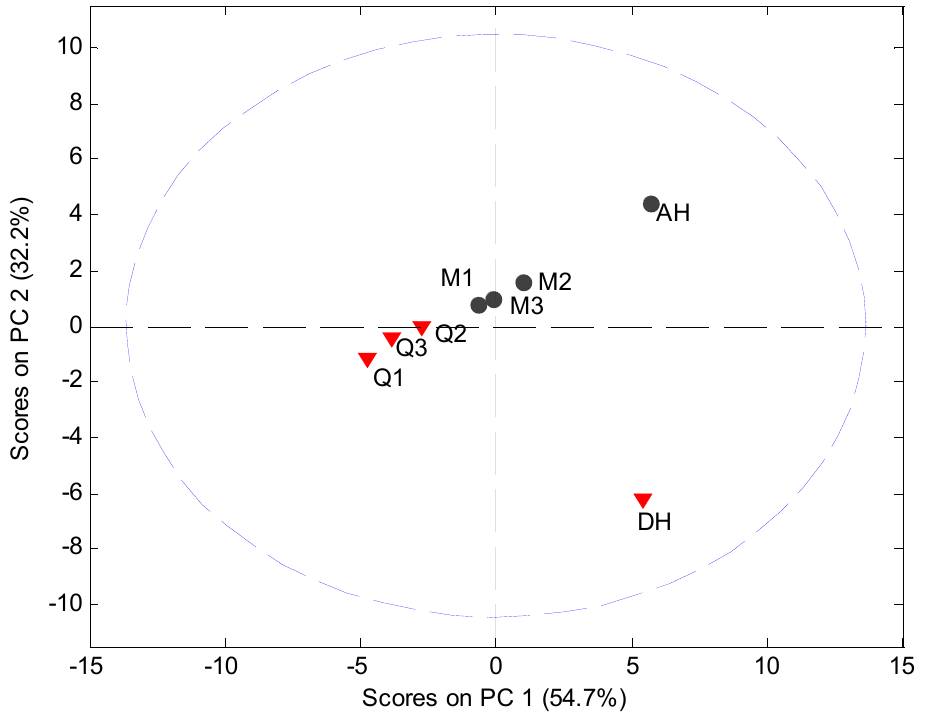
Figure 8. PCA score plot of PDF data (4 Å to 40 Å) using the 5° to 40° 2 θ XRPD diffraction range. Milled samples (M1, M2 and M3), quench cooled samples (Q1, Q2 and Q3), crystalline anhydrate (AH) and crystalline dihydrate